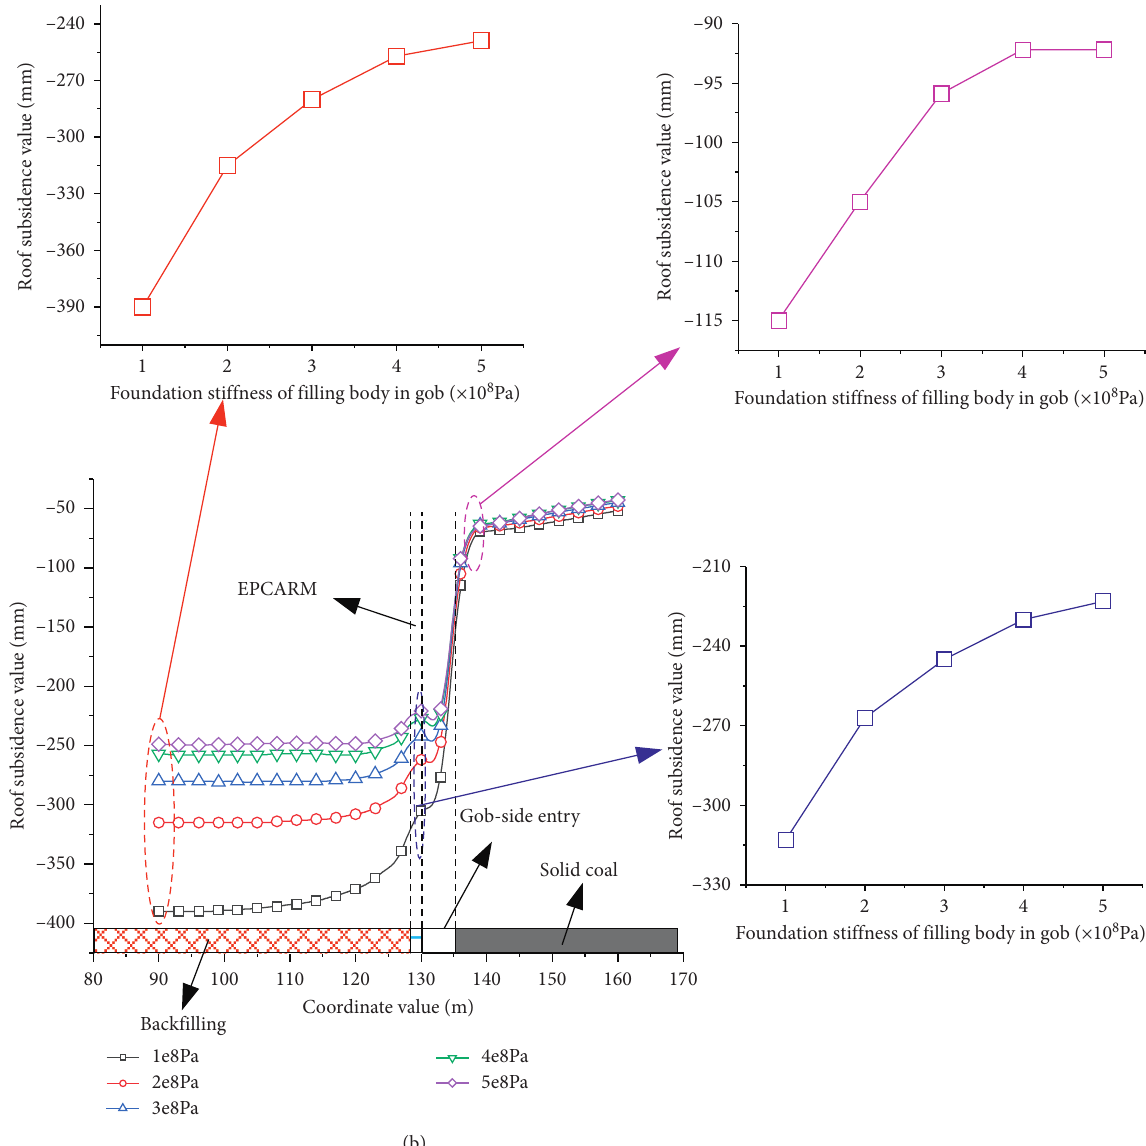
Figure 5: Roof deformation and stress variation for different foundation stiffness values of gob filling body. (a) Stress variation pattern. (b) Deformation variation